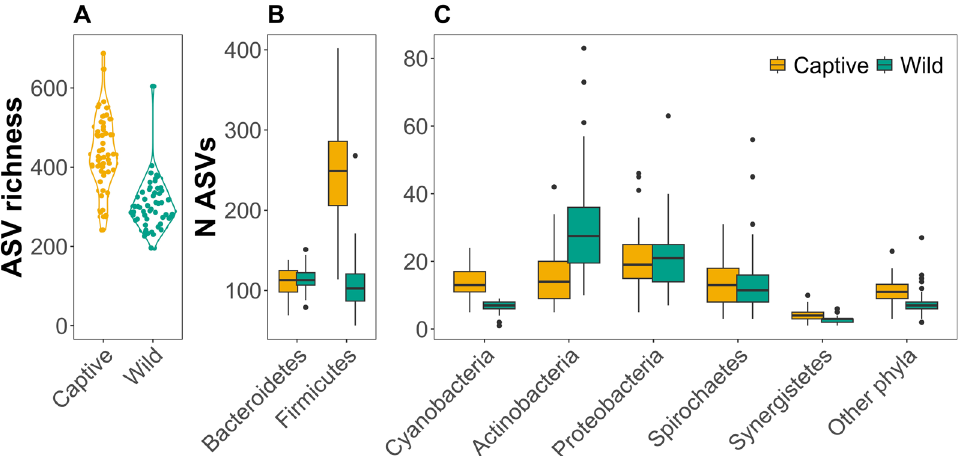
Fig. 4 ASV richness of fecal samples from wild and captive Damaraland mole-rats. A Violin plots of ASV richness of wild and captive Damaraland mole-rats. Each point represents a sample (N captive 53, N wild 56). B , C Boxplots of number of unique ASVs for the seven phyla with 100% = = prevalence within wild and captive faecal samples from the Damaraland mole-rat. A The two dominating phyla, Firmicutes and Bacteroidetes. B Cyanobacteria, Actinobacteria, Proteobacteria, Spirochaetes and Synergistetes and a box with the including other remaining phyla, representing the sum of unique ASVs within phyla not represented in all samples. Yellow boxes represent samples from captive individuals and blue-green boxes samples from wild individuals. Note the different y-axis scaling in panels B and